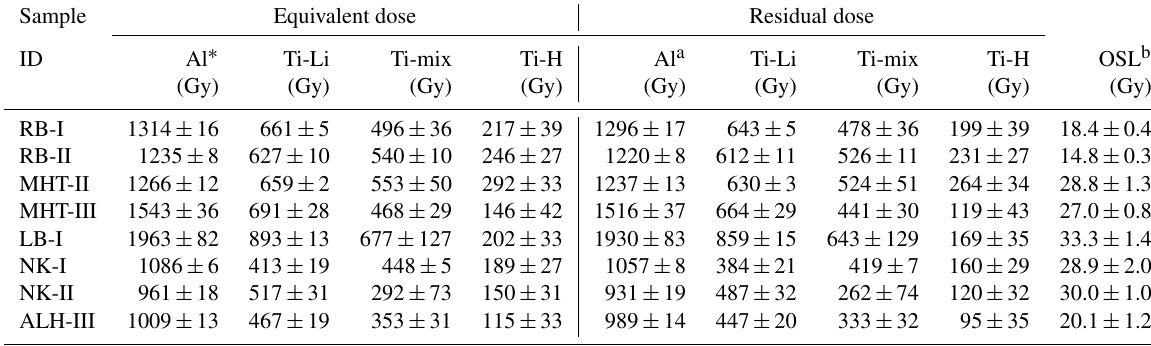
Table 2. Mean ESR equivalent doses ( D e ) and residual doses of the four signals compared with the mean OSL D e .